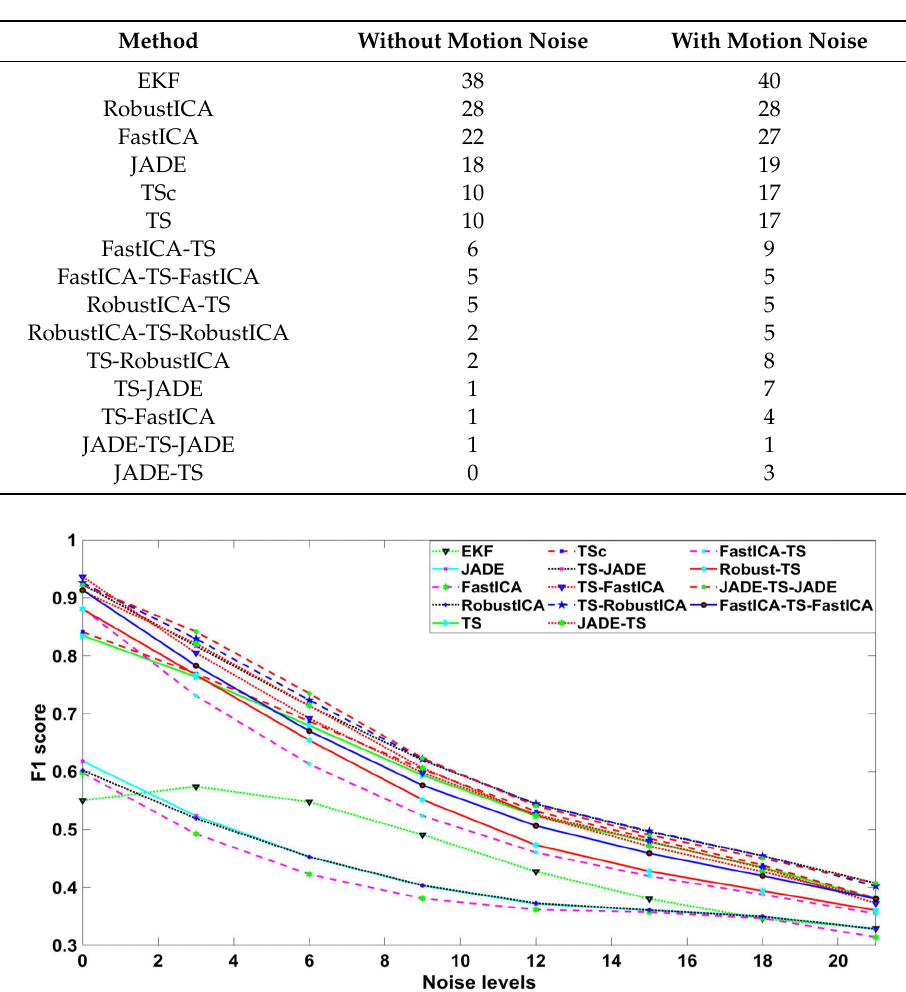
Table 2. Number of records out of 68 datasets with F1 scores less than 50%.